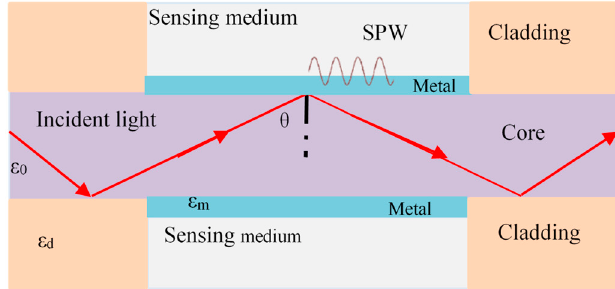
Figure 1. Schematic diagram of optical fiber SPR sensor.